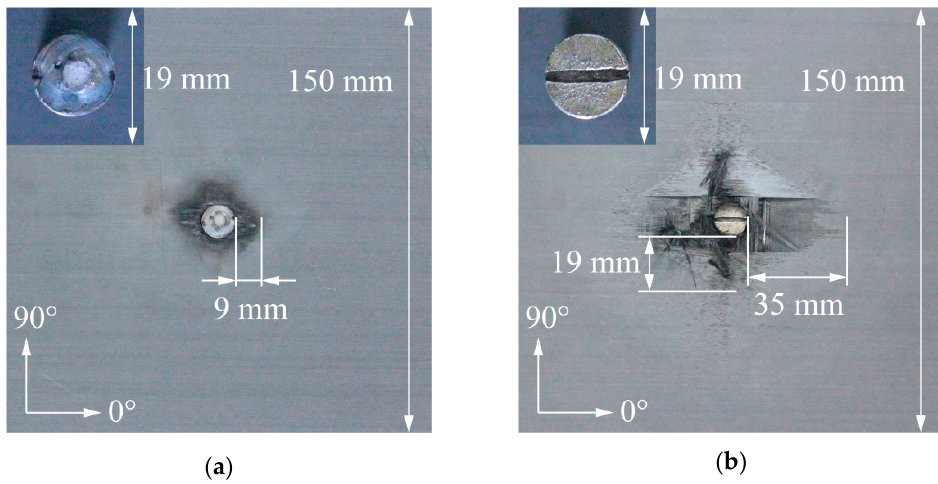
Figure 5. Surface damage in the specimens after lightning strike: ( a ) component C; ( b ) component D.